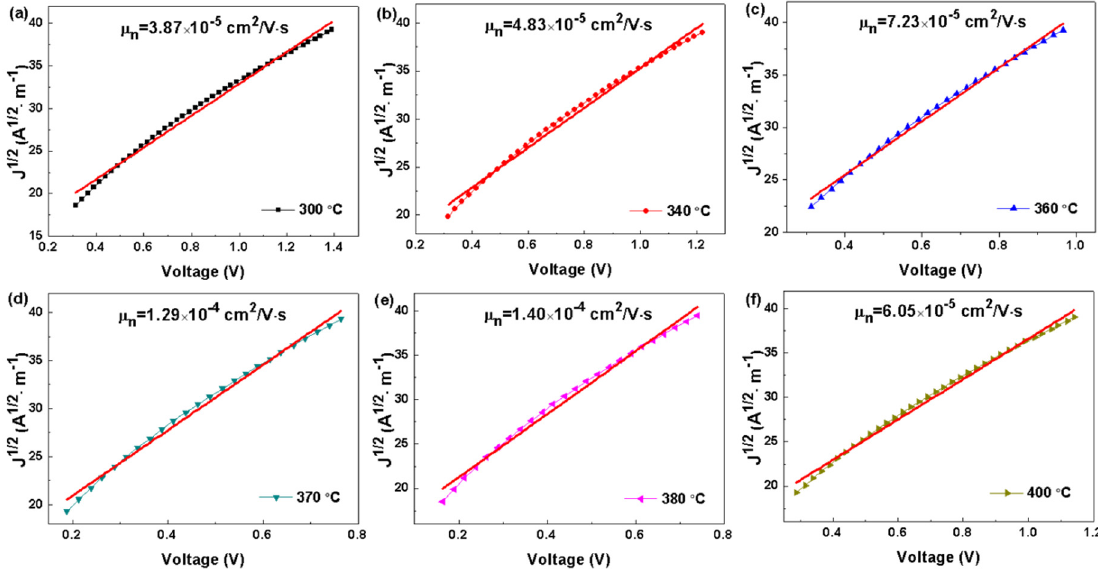
Figure 5. Linearly fitting SCLC measurements of CdS NC thin films under different annealing temperatures: ( a ) 300 °C; ( b ) 340 °C; ( c ) 360 °C; ( d ) 370 °C; ( e ) 380 °C; ( f ) 400 °C. ε 0 = 8.85 × 10 − 12 , ε r = 9, L = 160 nm. Table 2. Summarized electron mobility of CdS NC thin films with different annealing temperature (Figure 5).